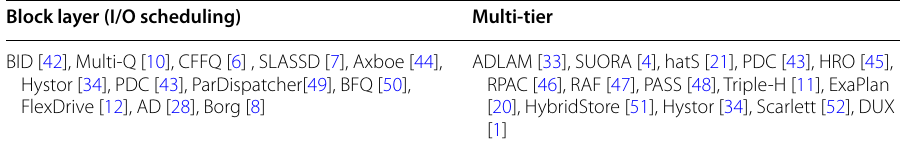
Table 4 Related works categorization Block layer (I/O scheduling)